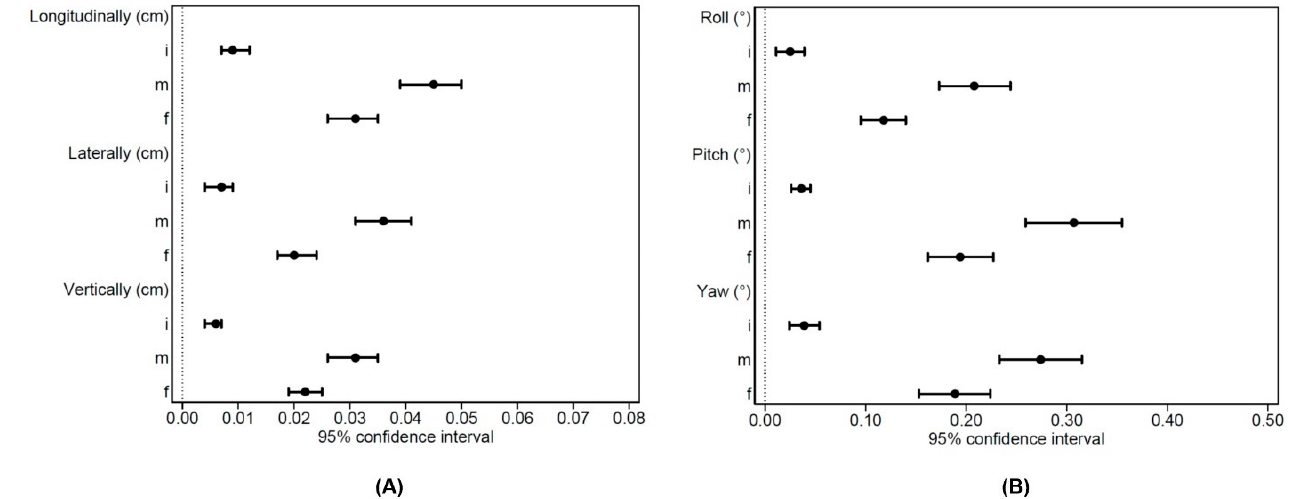
Figure 2. 95%CI for SGRT ( A ) translational and ( B ) rotational values.